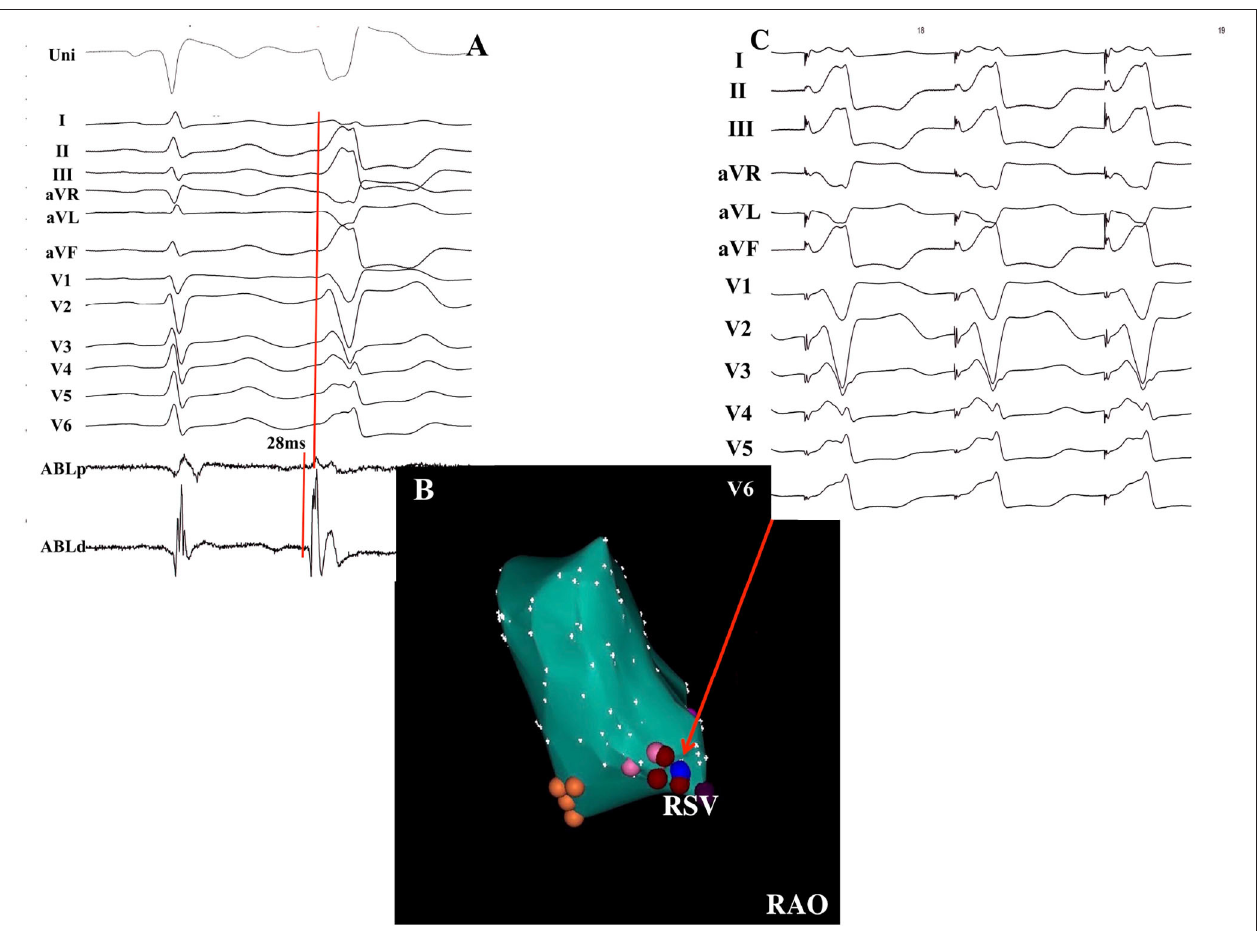
( Figure 4 ). In addition, patients with DPPs were more likely to have non-sustained or sustained VT rather than single PVC